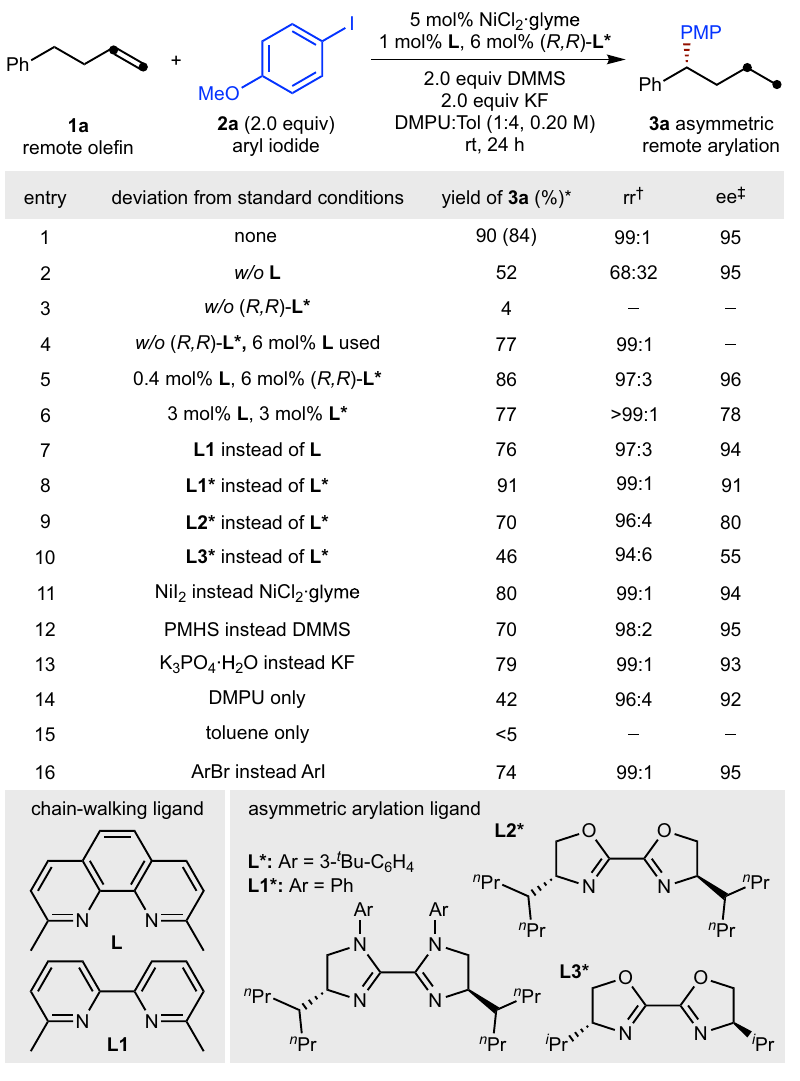
Fig. 2 Variation of reaction parameters. *Yields were determined by gas chromatography (GC) analysis using n -dodecane as the internal standard, the yield within parentheses is the isolated yield and is an average of two runs (0.20 mmol scale). † Regioisomeric ratio (rr) represents the ratio of the major (1,1-diarylalkane) product to the sum of all other isomers as determined by GC and GC-MS analysis. ‡ Enantioselectivities were determined by chiral HPLC analysis, the absolute con fi guration of 4t was determined by X-ray crystallography, and the con fi gurations of the remaining products were assigned by analogy. Glyme ethylene glycol dimethyl ether, DMMS dimethoxymethylsilane, DMPU N,N ′ -dimethylpropyleneurea, Tol toluene, PMP p -methoxyphenyl, PMHS